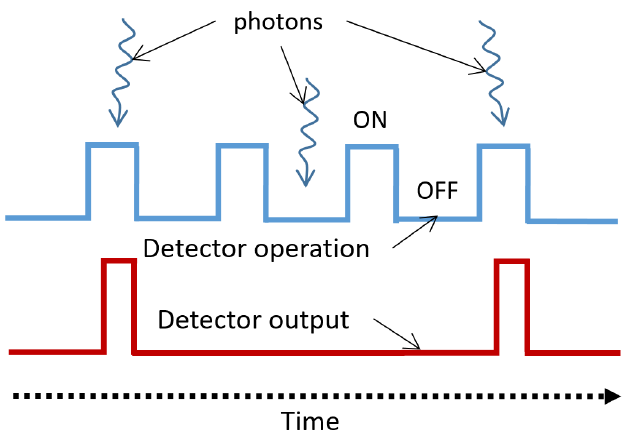
Figure 15. Time-gated